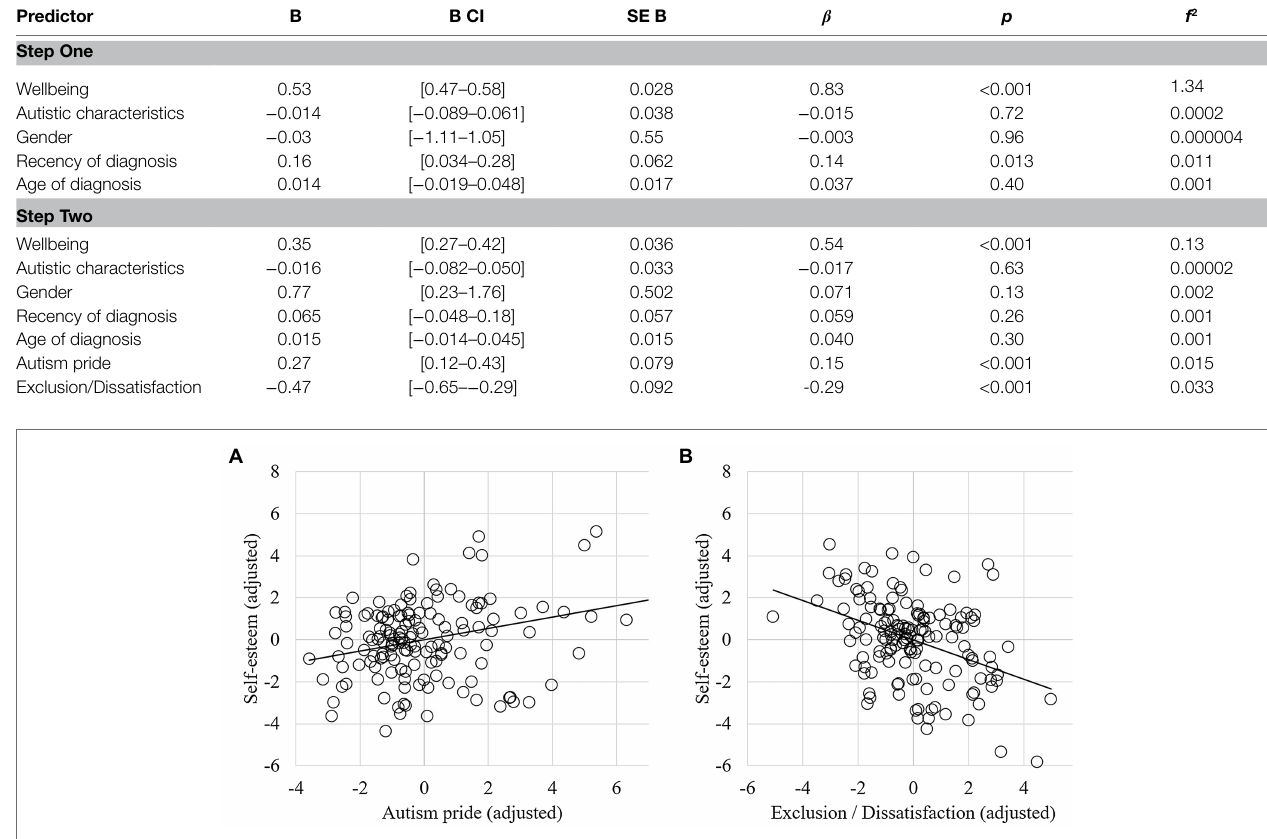
TABLE 5 | Hierarchical regression results with self-esteem as the outcome variable. Predictor